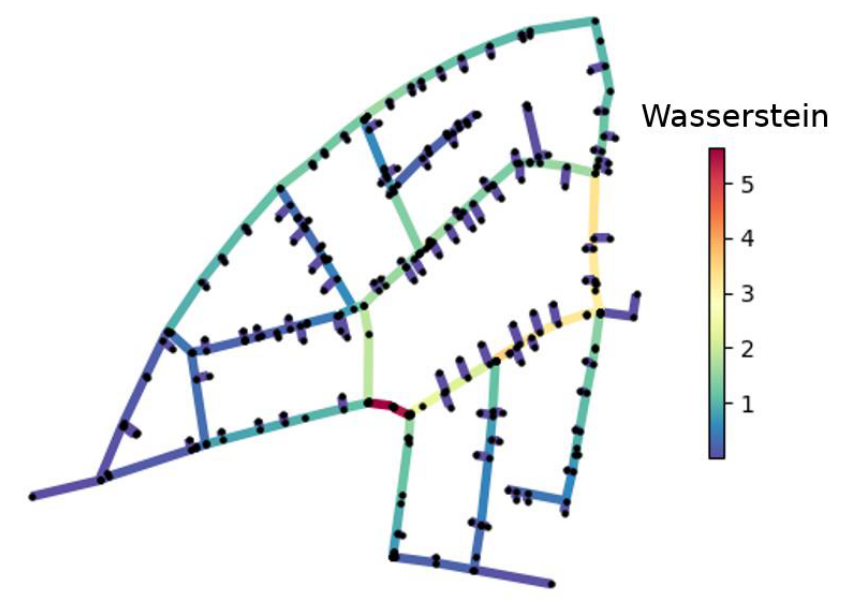
Figure 7. Heatmap of the Wasserstein distance for all edges in Figure 7 . Heatmap of the Wasserstein distance for all edges in Neptun.